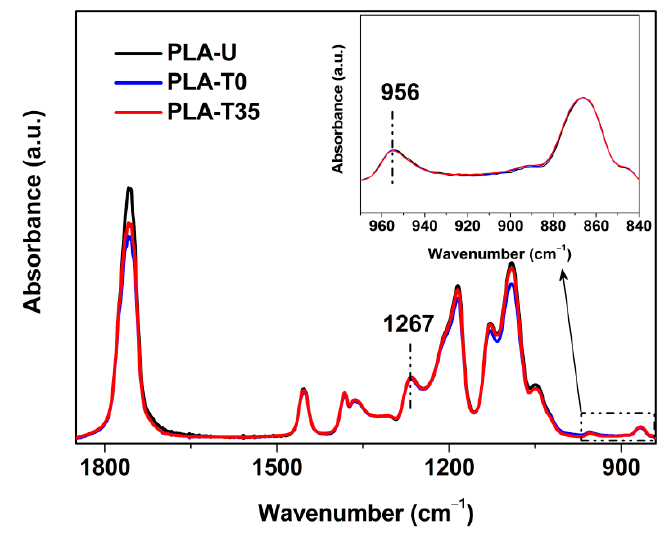
Figure 10. FTIR spectra in the 1850–840 cm − 1 and 970 − 840 cm − 1 (see the inset) ranges for PLA-U, PLA-T35, and PLA-T0 before further annealing.